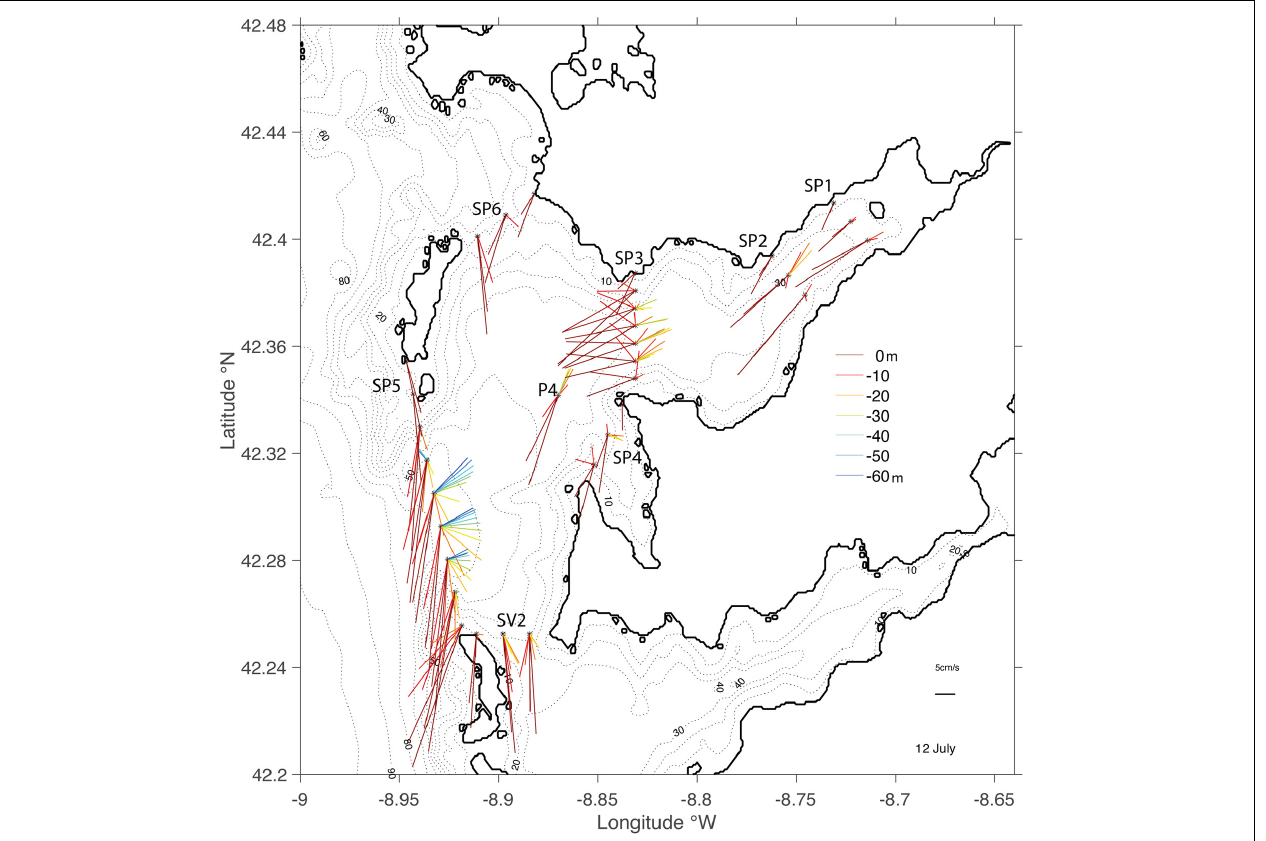
FIGURE 5 | Subtidal velocities (cm/s) at cross-sections and P4 station for 12 July at 13 h. The scale of colors of the sticks corresponds to the depths depicted by the bar, inner cross-sections, SP2 and SP1, represent velocities with light red and yellow. The velocity scale is displayed at the lower right